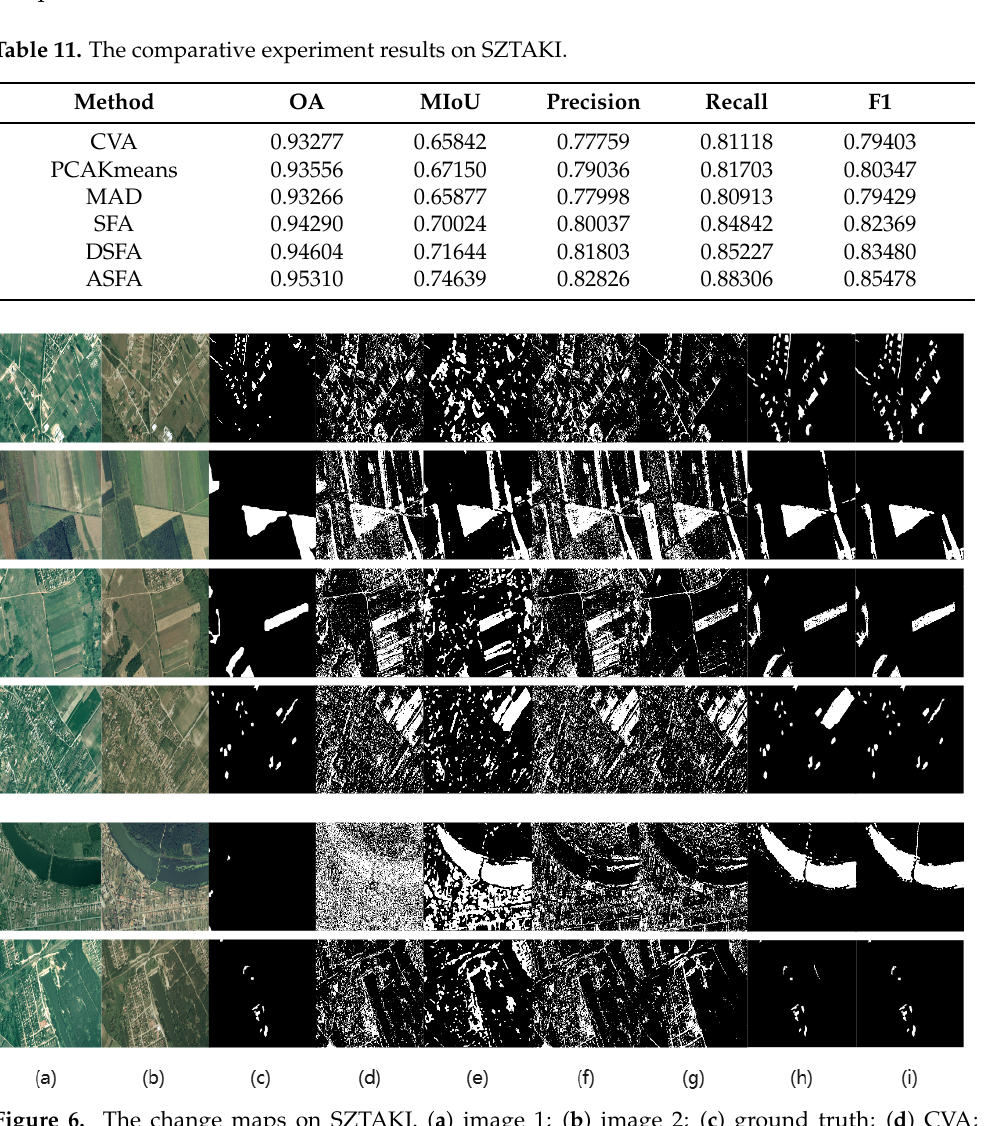
Figure 6. The change maps on SZTAKI. ( a ) image 1; ( b ) image 2; ( c ) ground truth; ( d ) CVA; ( e ) PCAKmeans; ( f ) MAD; ( g ) SFA; ( h ) DSFA; ( i )